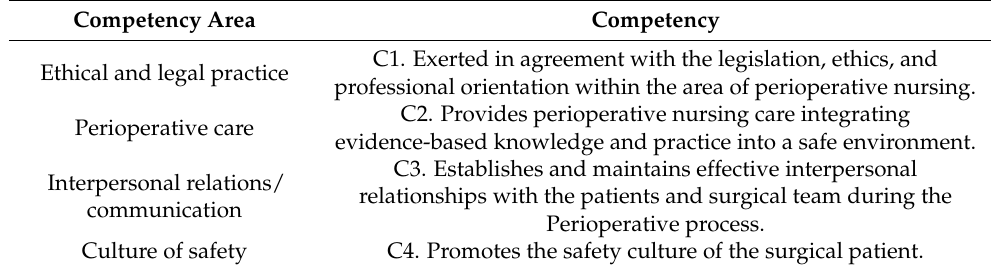
Table 1. This is a table of the competency areas and competencies of the final version of the CUCEQS© questionnaire.